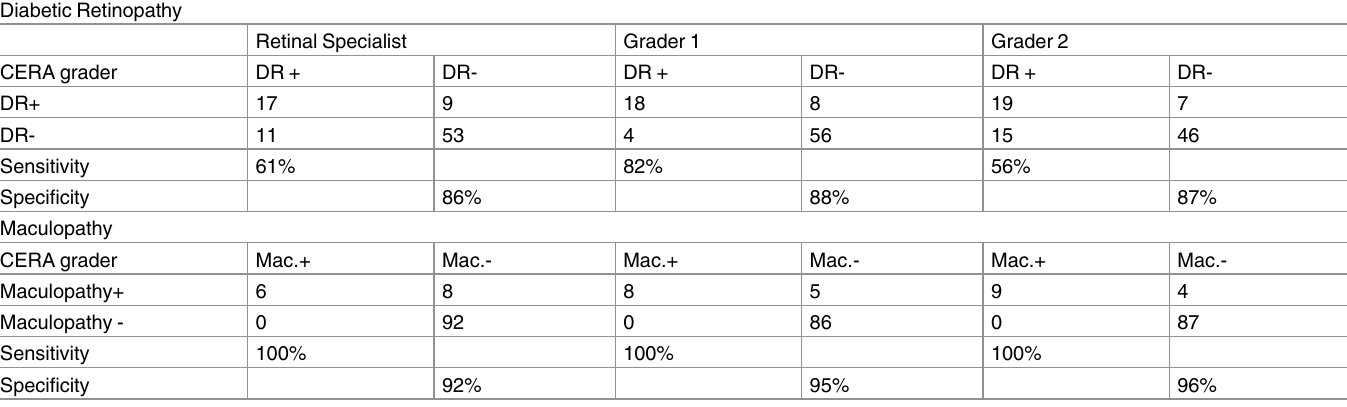
Table 9. Correctlyclassified retinal photos with and without DR, and with and without maculopathy by CERA grader, retinal specialist and the local graders before training through the test set. Diabetic